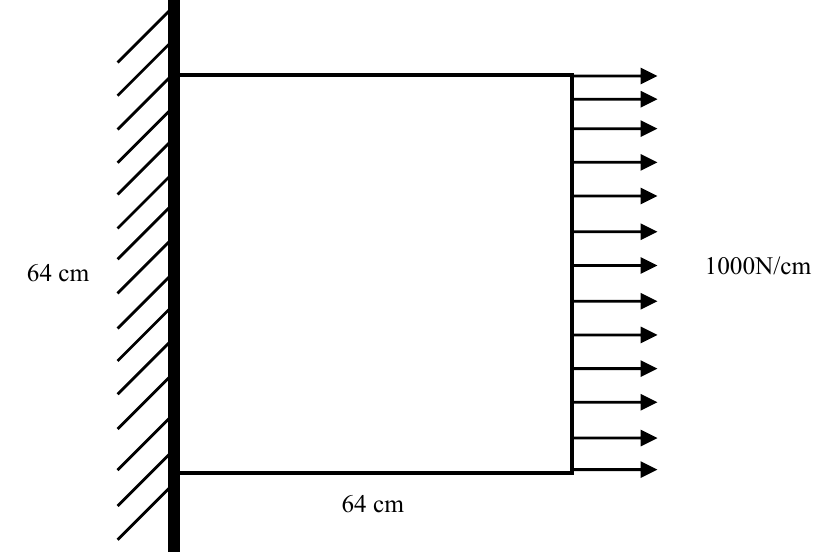
Figure 5. Schematic diagram of plate finite element